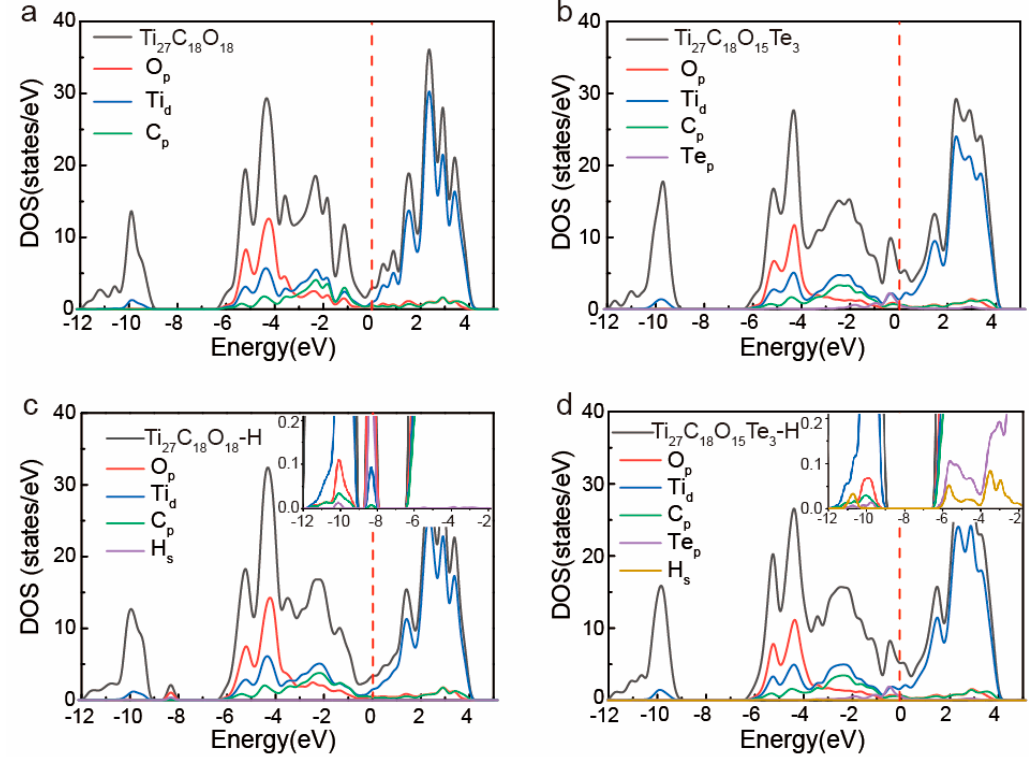
Figure 4. Density of states diagram. ( a , b ) total density of state (TDOS) and projected density of state (PDOS) of 2D- Ti 27 C 18 O 18 and Ti 27 C 18 O 17 Te 3 ; ( c , d ) TDOS and PDOS of 2D-Ti 27 C 18 O 18 and Ti 27 C 18 O 17 Te 3 after H adsorption; Fermi level is set to zero.